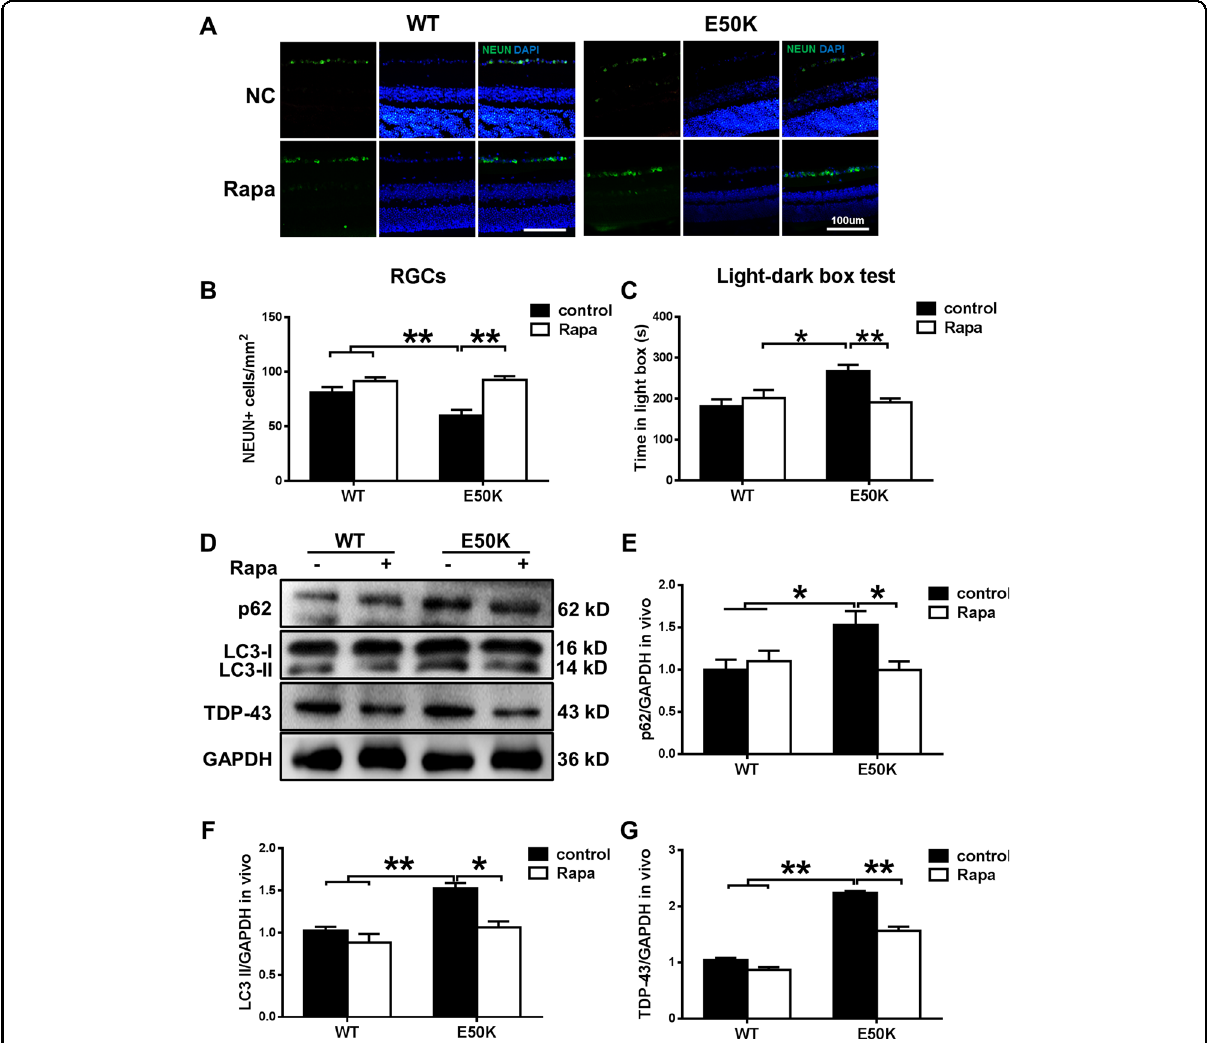
Fig. 7 The enhanced autophagy and reduced TDP-43 levels induced by rapamycin treatment decrease E50K-induced apoptosis. A, B After treatment with rapamycin, the RGC number in OPTN (E50K) mice signi fi cantly increased. Representative images and quanti fi cation of viable RGC immunolabelling by NEUN are shown. n = 20. C Light/dark transition test. The time spent in the light box was recorded. Rapamycin reduced the time spent in the light box by E50K mutant mice. n = 8. D Western blot analysis of p62/SQSTM1, LC3 and TDP-43 protein expression in the retinas of mice and E , F quanti fi cation of protein expression levels. G The expression of TDP-43 protein was signi fi cantly decreased after rapamycin treatment. n = 3. * P < 0.05; ** P <